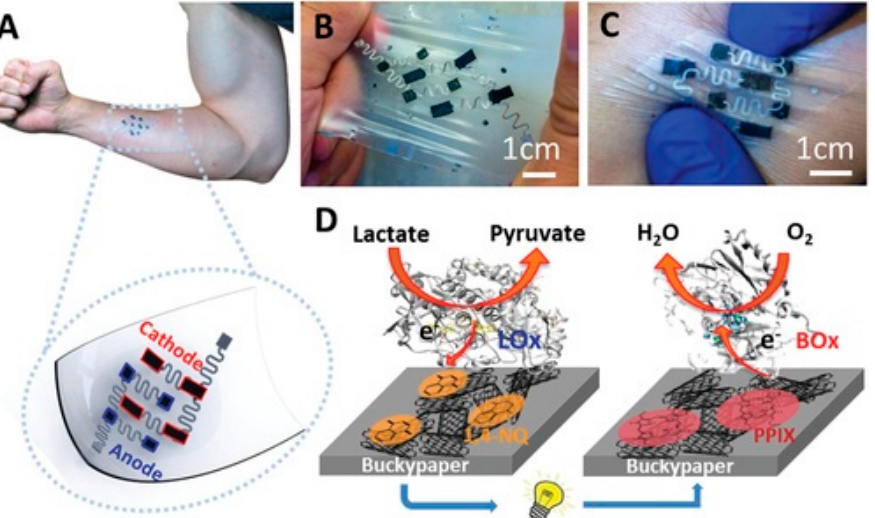
Figure 7. A stretchable biofuel cell sensor device mounted on a human arm ( top ) and the redox energy generation from the sweat lactate oxidation at the anode and oxygen reduction at the cathode ( bottom ) Reprinted with permission from [147]. 2019, Xiaohong Chen, Lu Yin, Jian Lv, et al. Additionally, wearable devices for both energy harvesting and storage have been presented. Lv et al. developed a flexible and stretchable textile-based hybrid device with both internal and external functionalized surfaces. In this design, the internal surface that was contacted to the body utilized energy harvesting from perspiration’s lactate oxidation, whilst the external surface comprises supercapacitors for energy storage. The biofuel also had the ability to act as a self-powered sensor where the sensor signal was proportional to the lactate concentration and to the output power